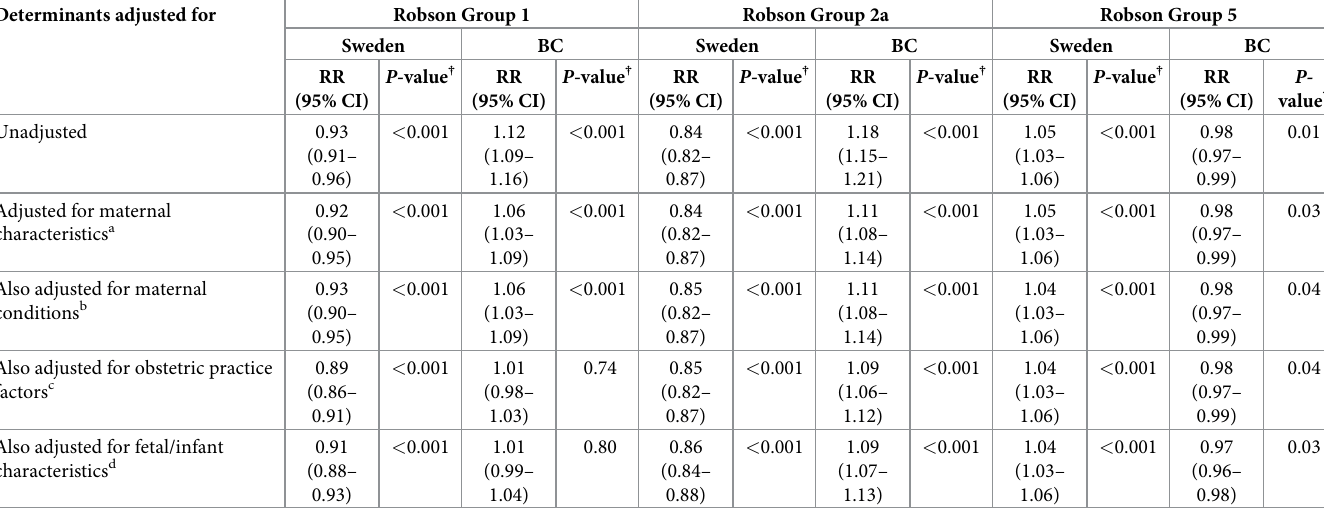
Table 4. Unadjusted and adjusted rate ratios for CD in 2014–2016 vs. 2004–2007 among women in Robson Groups 1, 2a, and 5 after sequential adjustment � for maternal characteristics, obstetric practice factors, and fetal/infant characteristics, Sweden and BC,